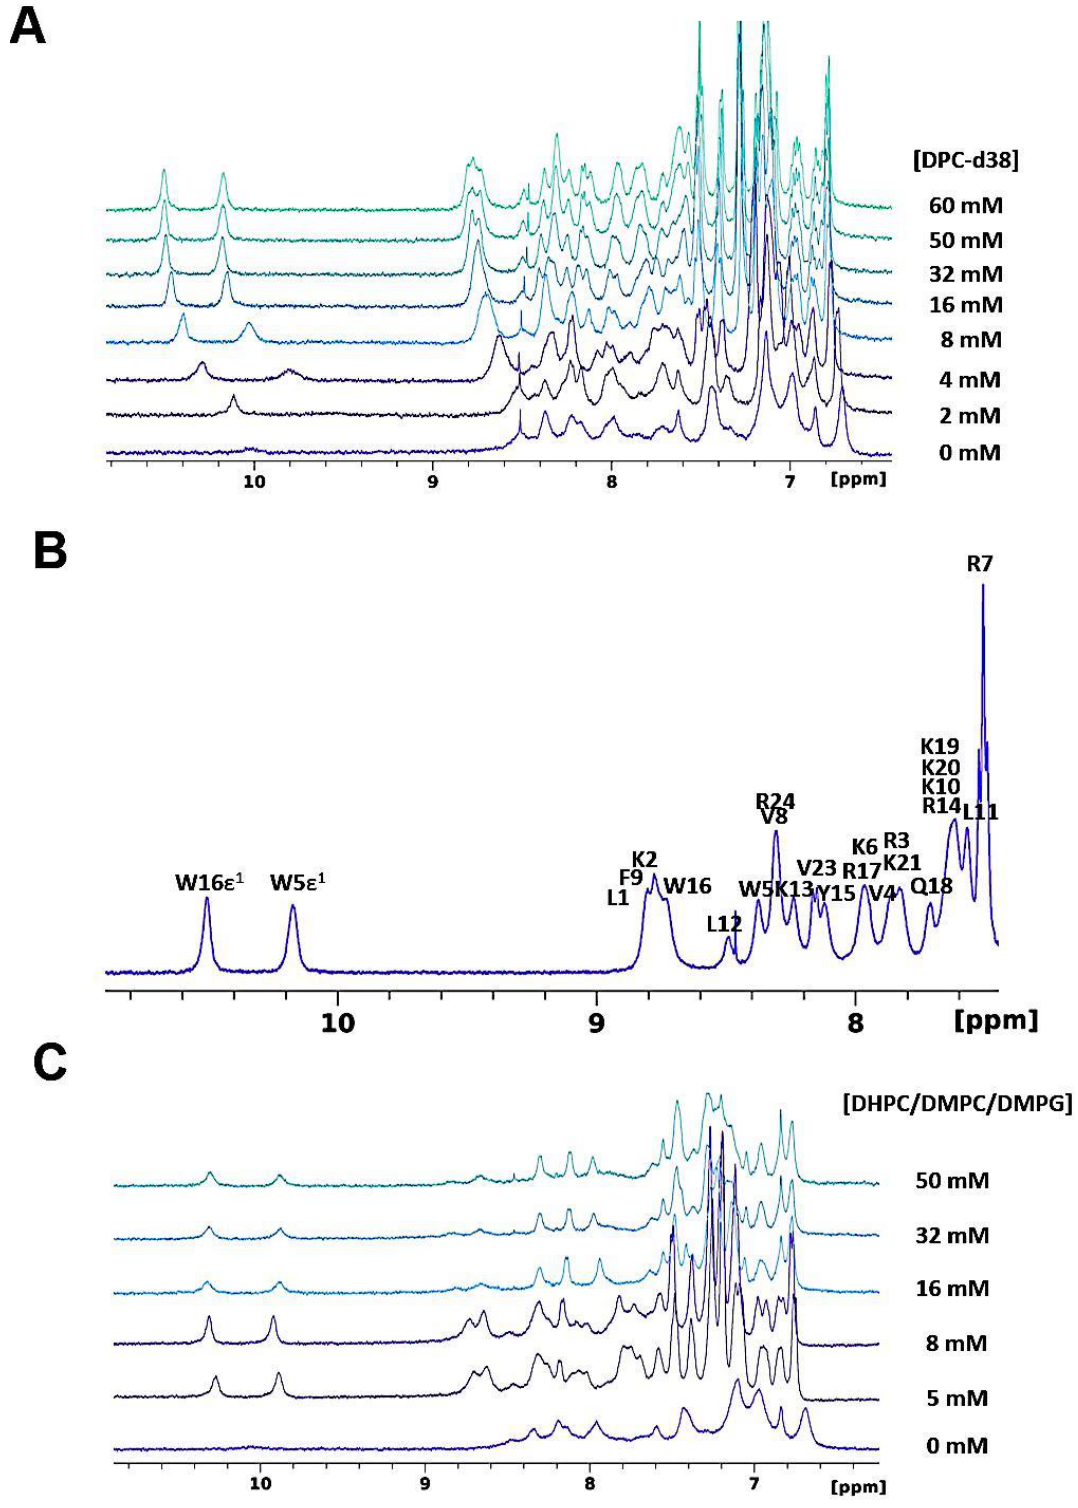
Figure 1. ( A ) The 500 MHz 1 H NMR spectra (amide and aromatic region) recording during the titration of SAAP-148 with DPC:d38 micelles up to a concentration of 60 mM. ( B ) NMR assignment of the amide region of SAAP-148 in DPC micelles. ( C ) The 500 MHz 1 H NMR spectra of the titration of SAAP-148 with DHPC/DMPC/DMPG isotropic bicelles up to a concentration of 50 mM. The temperature was 310 K.